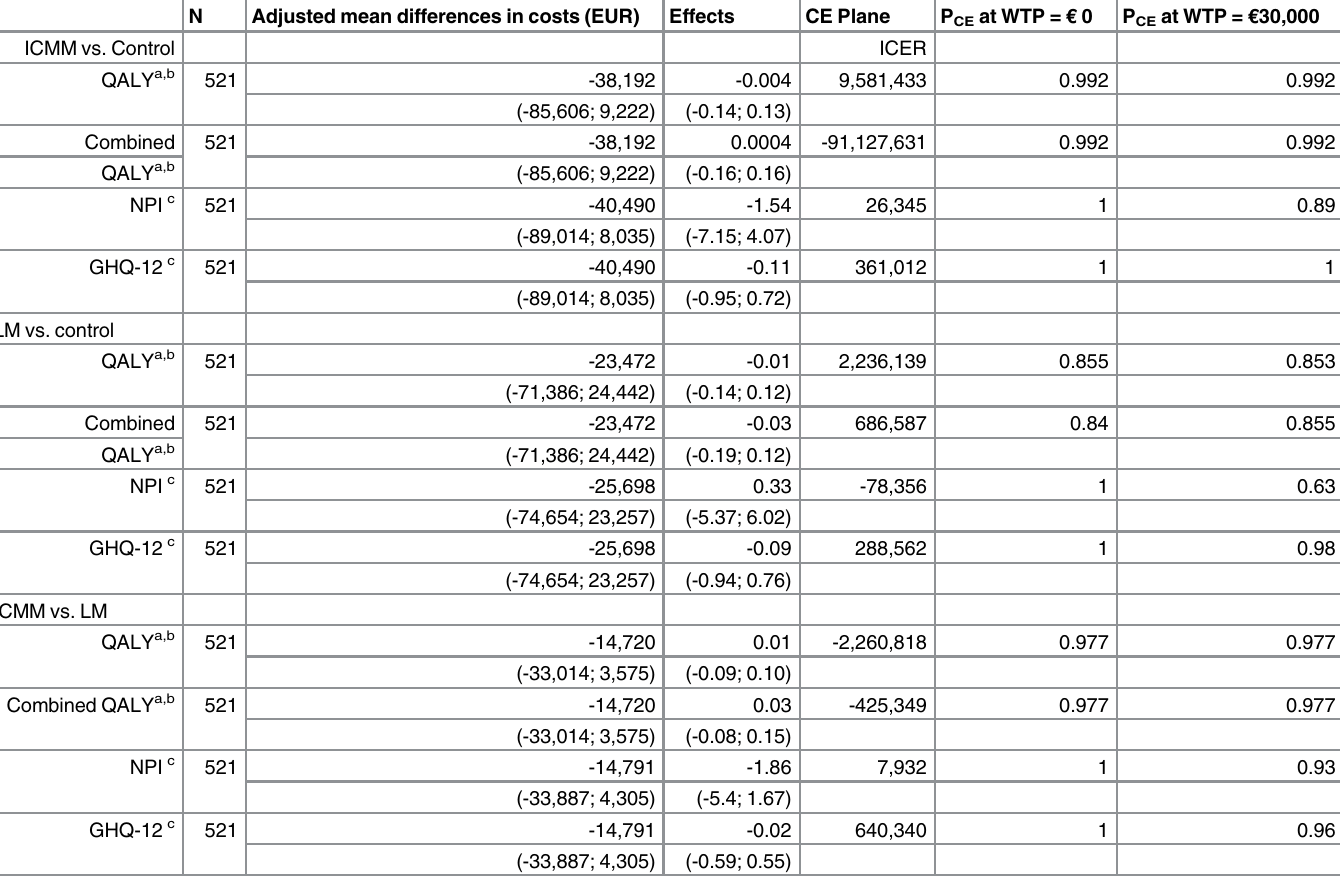
Table 4. Adjusted mean differences in outcomes and